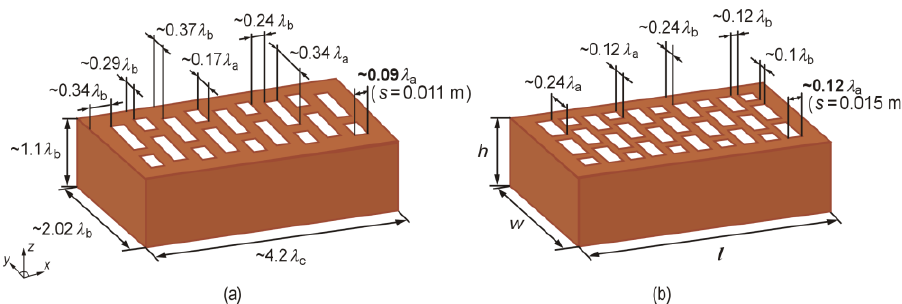
Figure 2. Relative dimensions of two types of analyzed bricks for f = 2.4 GHz: ( a ) model B18 and ( b ) model B30.